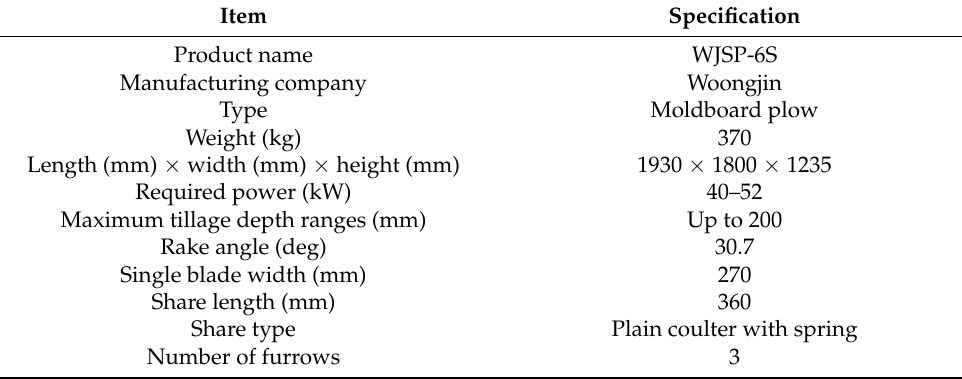
Table 2. Specification of the tillage